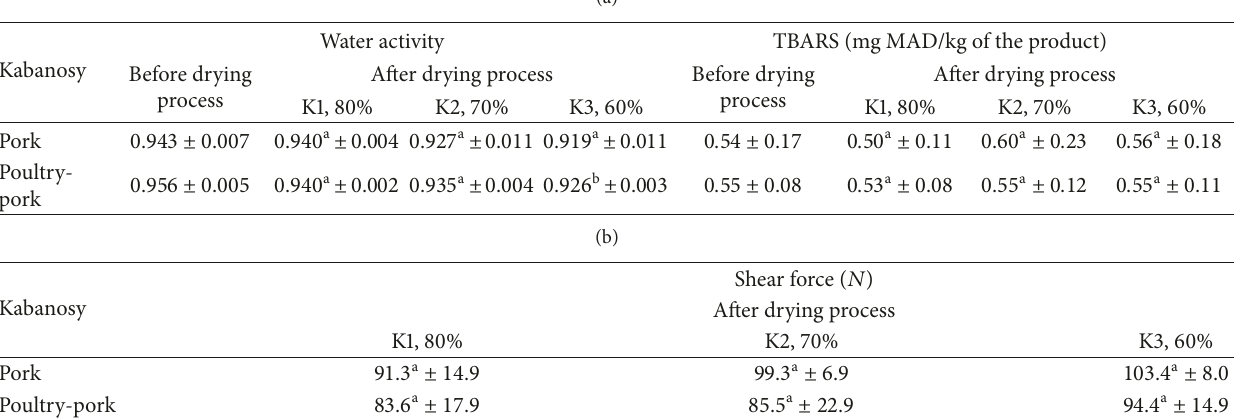
Table 3: Water activity ( 𝑎 𝑤 ) and TBARS indicator values in pork and poultry-pork kabanosy before and after the drying process; shear force value after drying process.